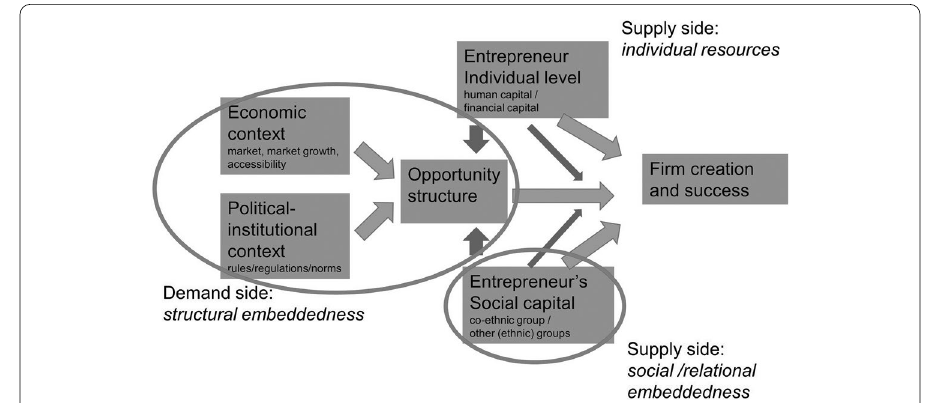
Fig. 1 Schutjens’ mixed embeddedness model. Source : Schutjens